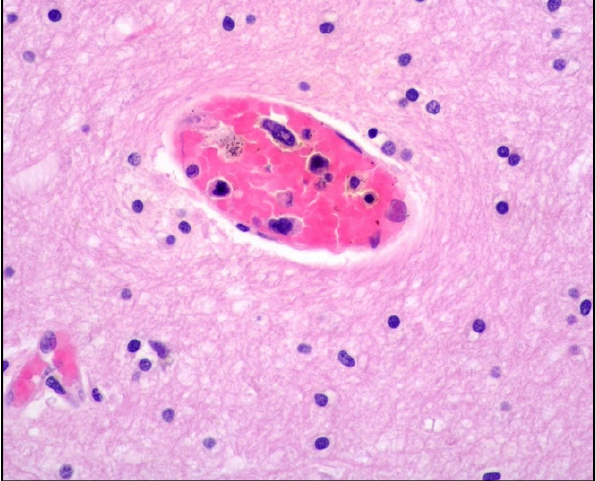
Figure 2. High-power view showing central nervous system parenchyma with atypical cells within a vascular space (hematoxylin and eosin, 400× magnification, previously unpublished, original image from S.A.).